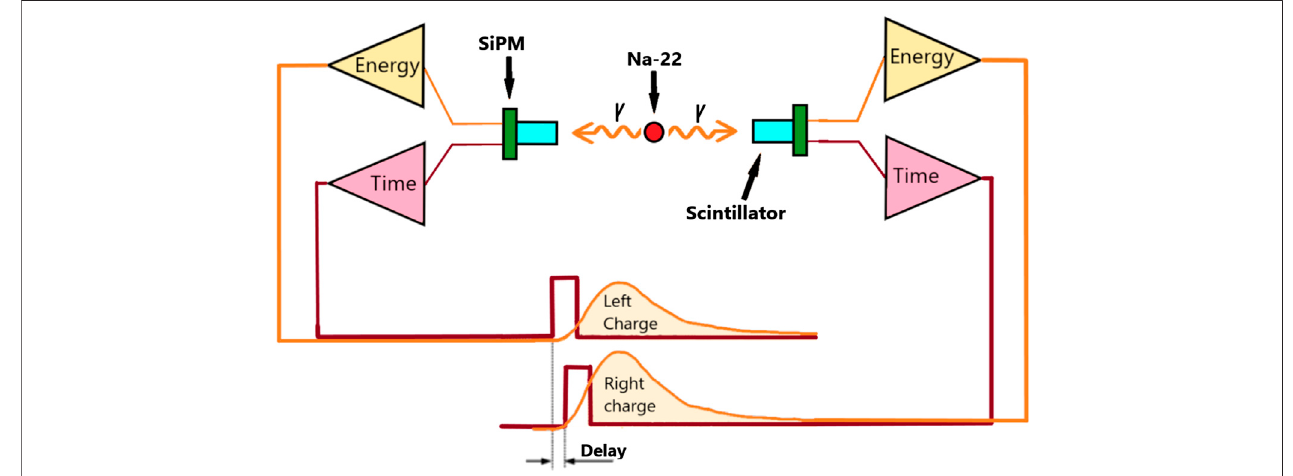
FIGURE 3 | Illustration of the coincidence time resolution (CTR) setup, based on ref. [8].